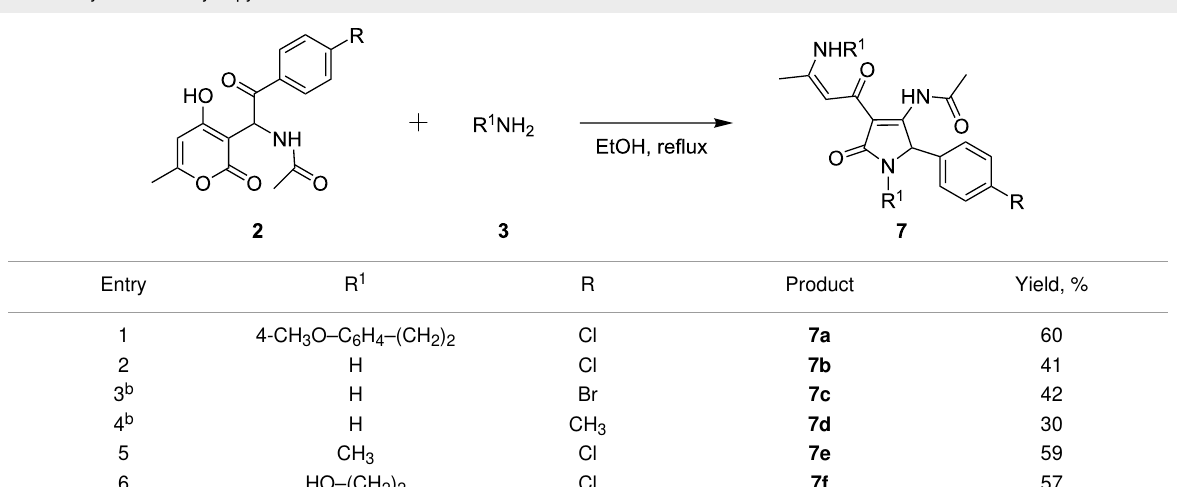
Table 2: Synthesis of dihydropyrrolone derivatives 7 .